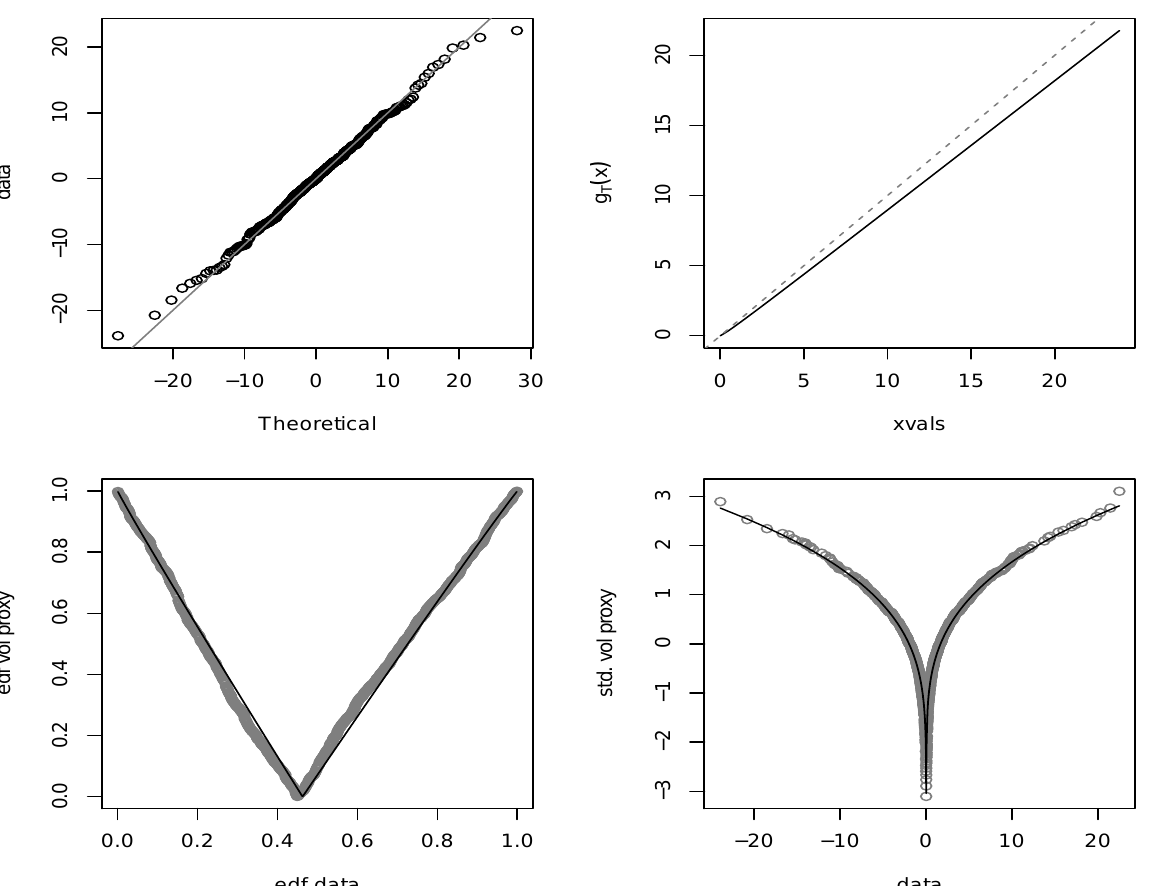
Figure 6. Plots for a VT(2)-ARMA(1,1) model combined with a double Weibull marginal distribution fitted to the Bitcoin return data: QQplot of the data against fitted double Weibull model ( upper left ); estimated volatility proxy profile function g T ( upper right ); estimated v-transform ( lower left ); implied relationship between data and volatility proxy variable ( lower right